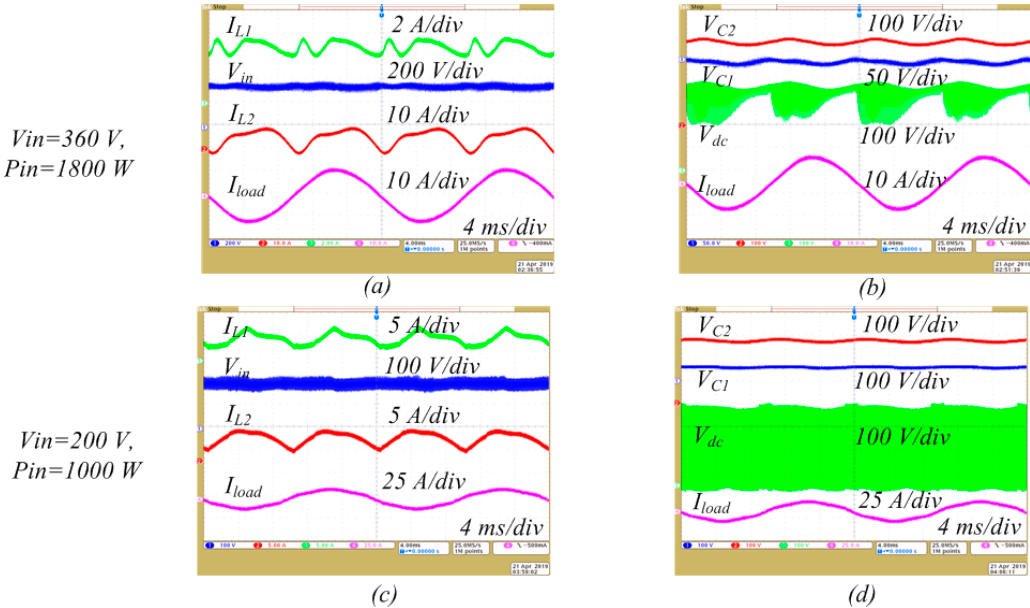
Figure 6. Operation waveforms of 2L QZSI at a nominal power level of 1800 W ( a , b ) and in boost voltage mode at a reduced power level of 1000 W ( c , d ).